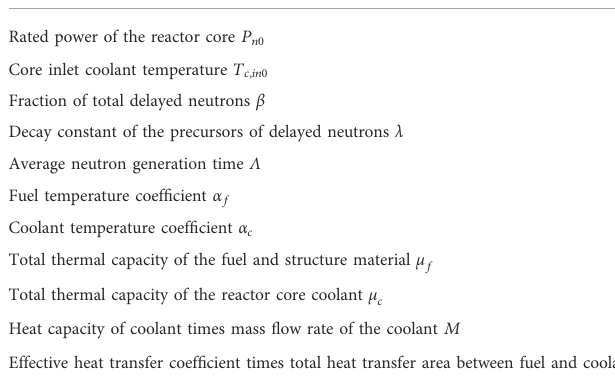
TABLE 1 Neutronic and thermohydraulic parameters of the core model for the lithium-cooled space nuclear reactor. Parameter Value Unit Rated power of the reactor core P n